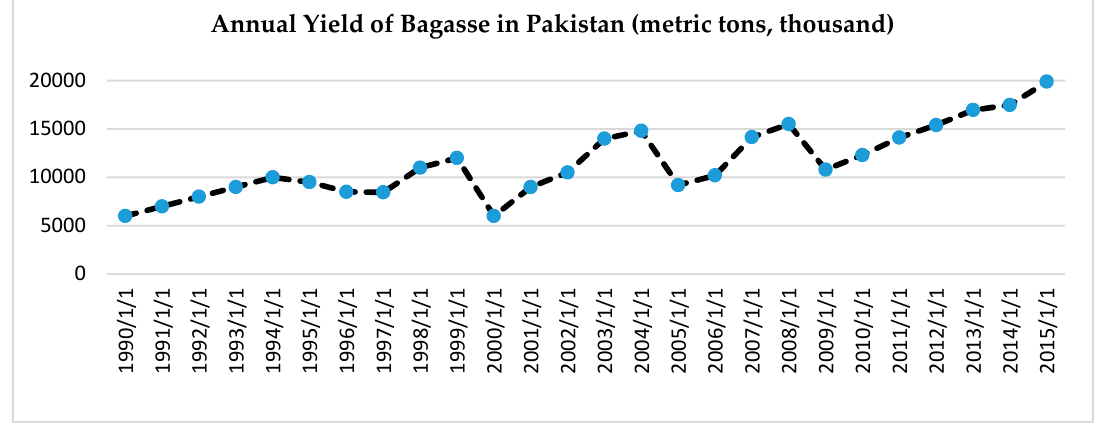
Figure 19 . Bagasse yield per annum in Pakistan from 1990–2015. Figure 19. Bagasse yield per annum in Pakistan from